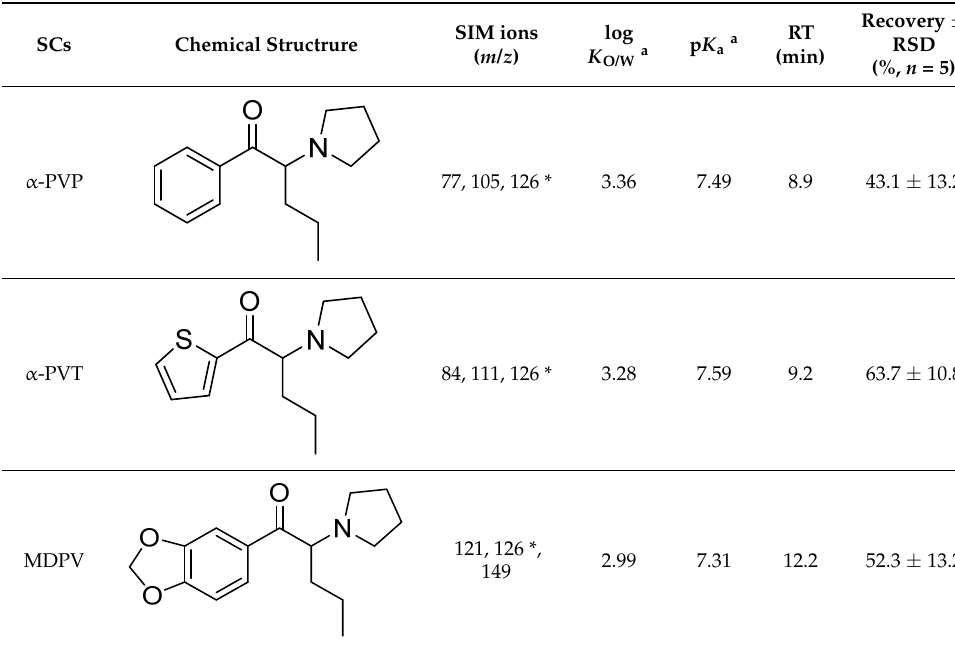
Table 1. Structures, log K O/W , p K a, retention times (RT), average recovery yields, and the precision (expressed in RSD) obtained for the three SCs by BA µ E(Strata-X)- µ LD/GC-MS(SIM) in oral fluid samples under optimized experimental